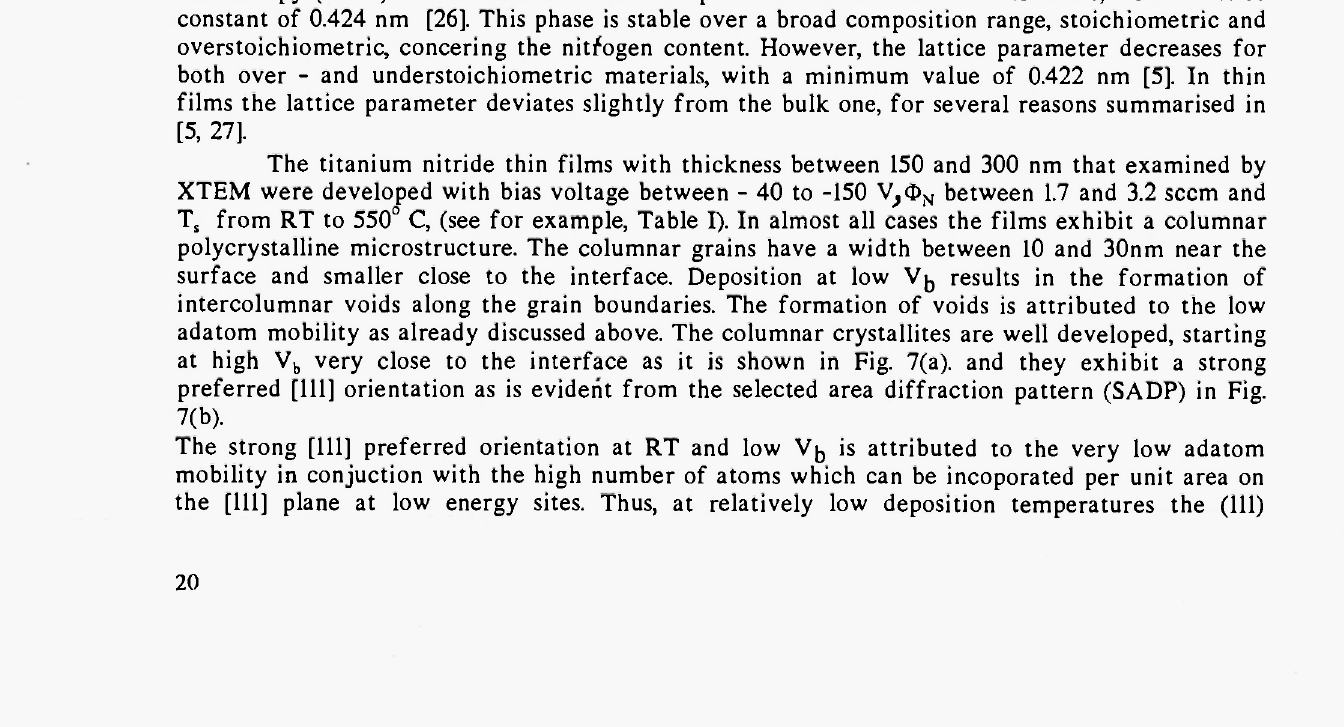
Fig.6 The dependence of TiN* films microhardness on bias voltage.